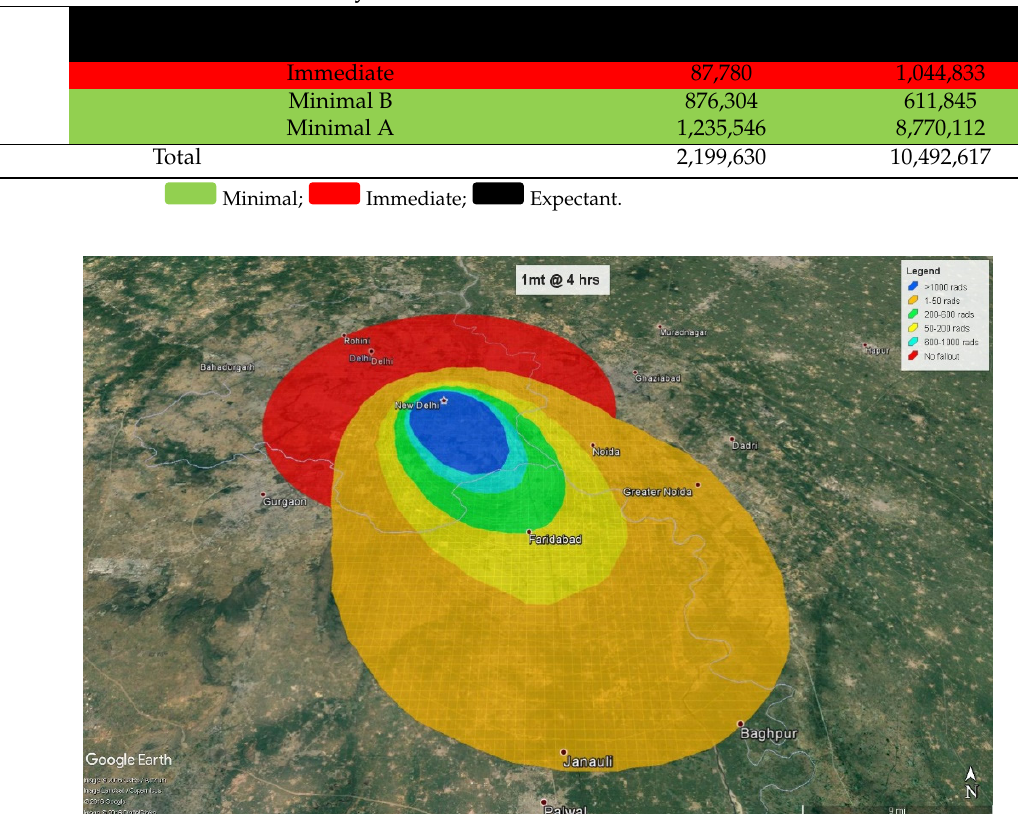
Figure 9. 1 mt fallout radiation plume at 4 h.